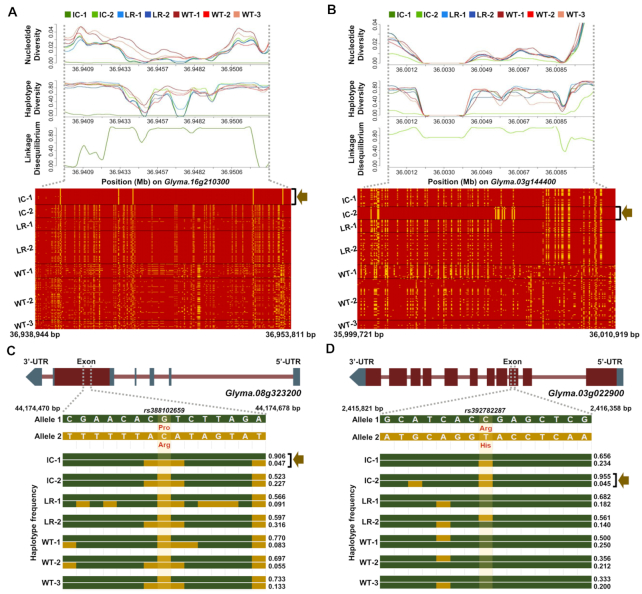
Selection signatures for the IC-1 and IC-2 subgroups. A, B, Patterns of nucleotide diversity, haplotype diversity, and linkage disequilibrium (top) and the degree of haplotype sharing among all subgroups (bottom) in Glyma.16g210300 and Glyma.03g144400. The Glyma.16g210300 and Glyma.03g144400 genes are located at 36,943,073–36,948,828 bp on chromosome 16 and at 36,004,707–36,005,955 bp on chromosome 3, respectively. All 7 subgroup lines are shown for the nucleotide and haplotype diversities. For clarity of the subgroup lines, only the IC-1 and IC-2 subgroup lines are shown for the linkage disequilibrium. Detailed illustrations of the 3 patterns are provided in Supplementary Figs S12a–c and S14a–c. The plots for the degree of haplotype sharing are displayed for all variants in the entire regions of 2 genes, and the major and minor alleles of each variant are presented in red and yellow, respectively. C, D, Gene structures and haplotype frequencies for regions containing 1 missense variant in Glyma.08g323200 and Glyma.03g022900, respectively. The gene structures are displayed on the top, and regions containing the missense variant and its surrounding 14 variants are drawn beneath them. Reference and alternative alleles (Allele 1 and 2) are presented in green and yellow, and missense variants are highlighted in light yellow. The missense variants of the Glyma.08g323200 and Glyma.03g022900 genes are located at 44,174,550 bp on chromosome 8 (p.Pro191Arg on rs388102659) and at 2,415,948 bp on chromosome 3 (p.Arg560His on rs392782287), respectively. The haplotype structures for those regions are depicted below the gene structures, with haplotype frequencies shown to the right. Only the top 2 haplotype frequencies are displayed for each subgroup owing to illustration constraints. Information regarding all haplotype frequencies is provided in Additional File 5.